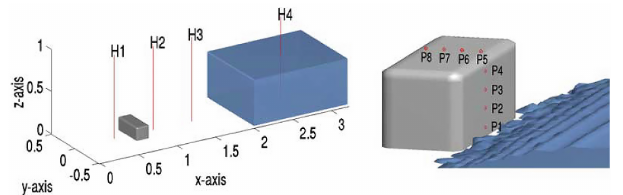
Figure 3. Measurement positions for water heights and pressures in the dam-break experiment (from Kleefsman et al., 2005). P1 to P8 are pressure probes, and H1 to H4 are height